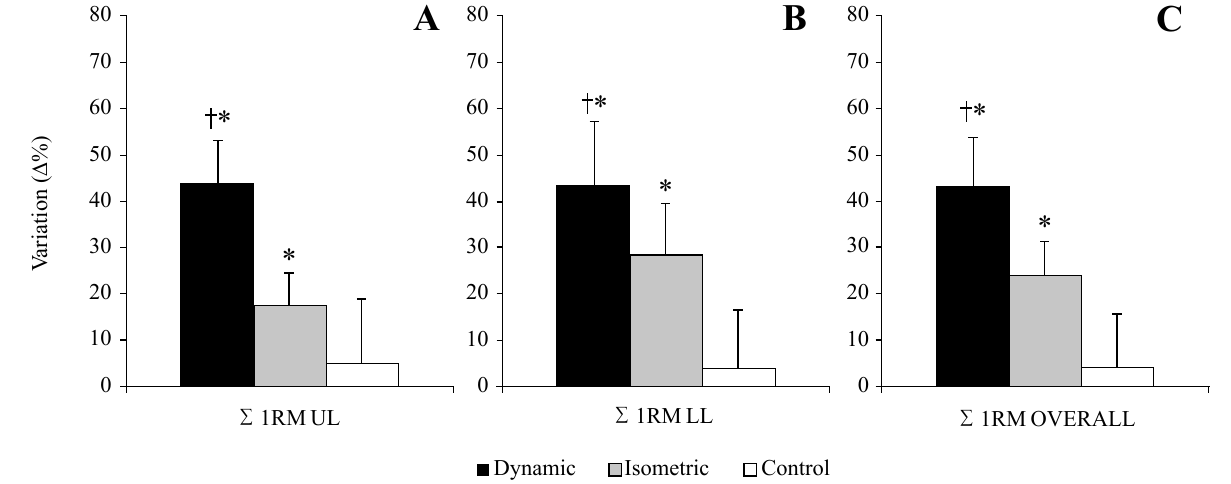
Figure 4. Mean (±SD) of variation percentage (∆%) of strength obtained through of one-repetition maximum test at the different